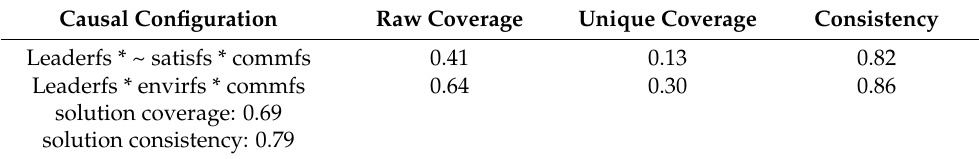
Table 4. Results of the intermediate solution (outcome: